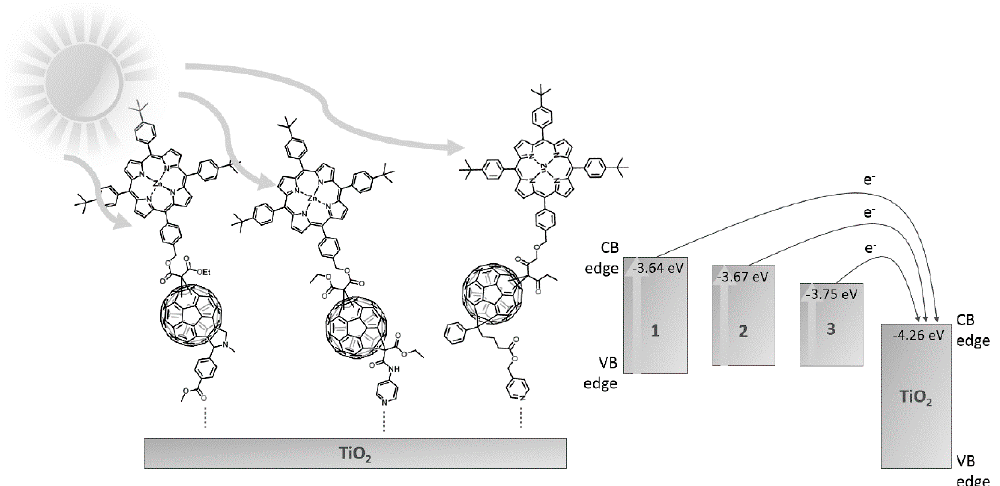
Figure 9. The proposed mechanism of the photocatalytic activity of the porphyrin-functionalized fullerenes/titania composites.